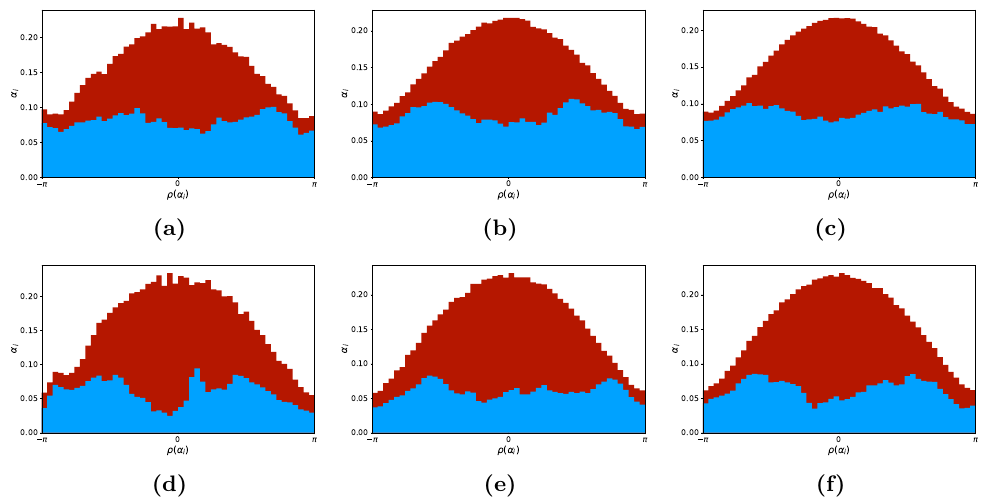
Figure 13. Polyakov loop phase distributions for N = 32 and N = 64 , n t = 24 , P = 0 . 2 (top) and P = 0 . 25 (bottom), for constraints of the second kind. In addition to the distribution of all phases, the ‘deconfined part’ ( α 1 , · · · , α M ) and ‘confined part’ ( α M +1 , · · · , α N ) are